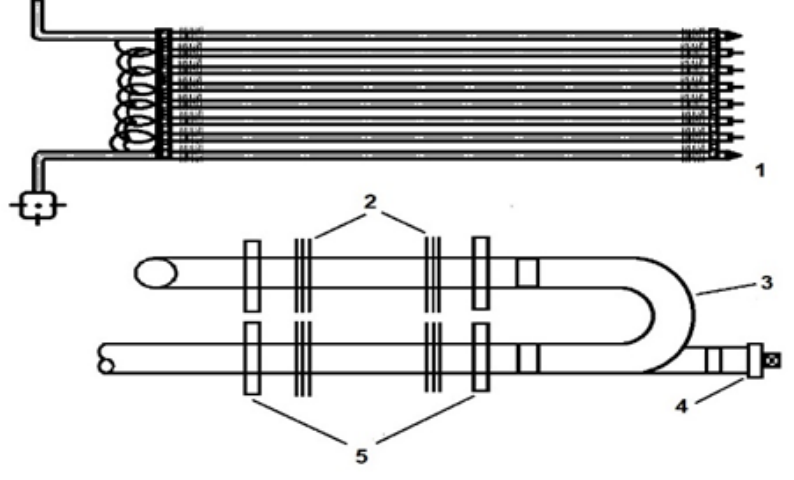
Figure 4. Feed water boiler heater [7]. 1 — steel pipe; 2 — fins; 3 — elbow; 4 — cleanout; 5 — flange.